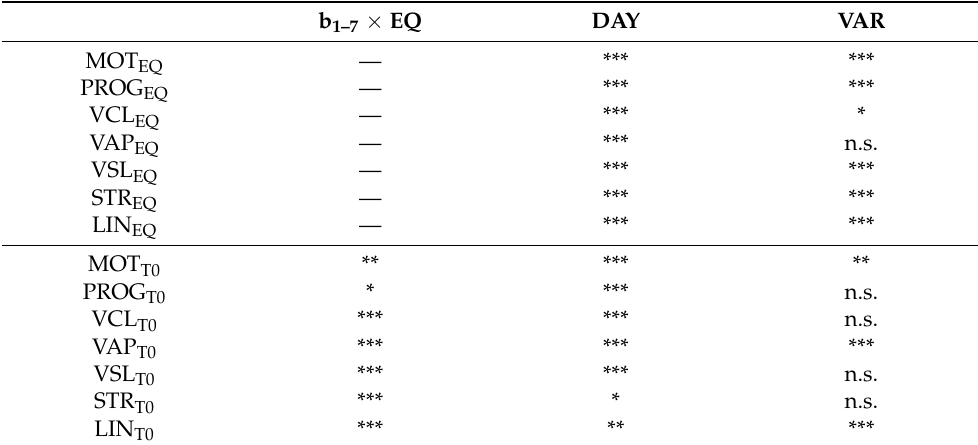
Table 1. Significance of factors used in statistical models for CASA